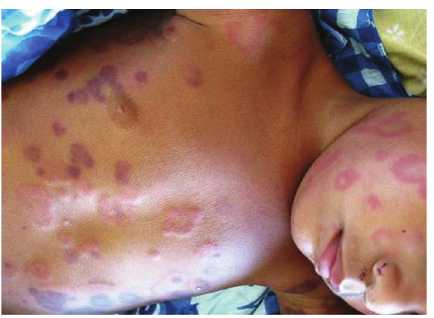
Figure 2: Second eruption featuring small urticarial papules on face, trunk, and